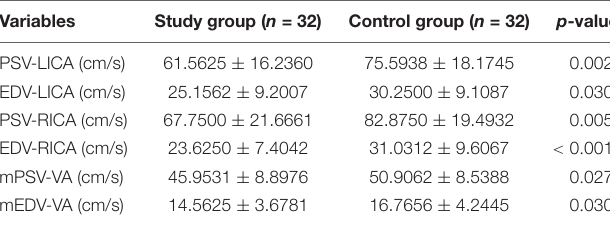
TABLE 4 | Results from multiple linear regression of the extracranial artery flow velocity, ATT on CBF in the anterior and posterior circulations of the study